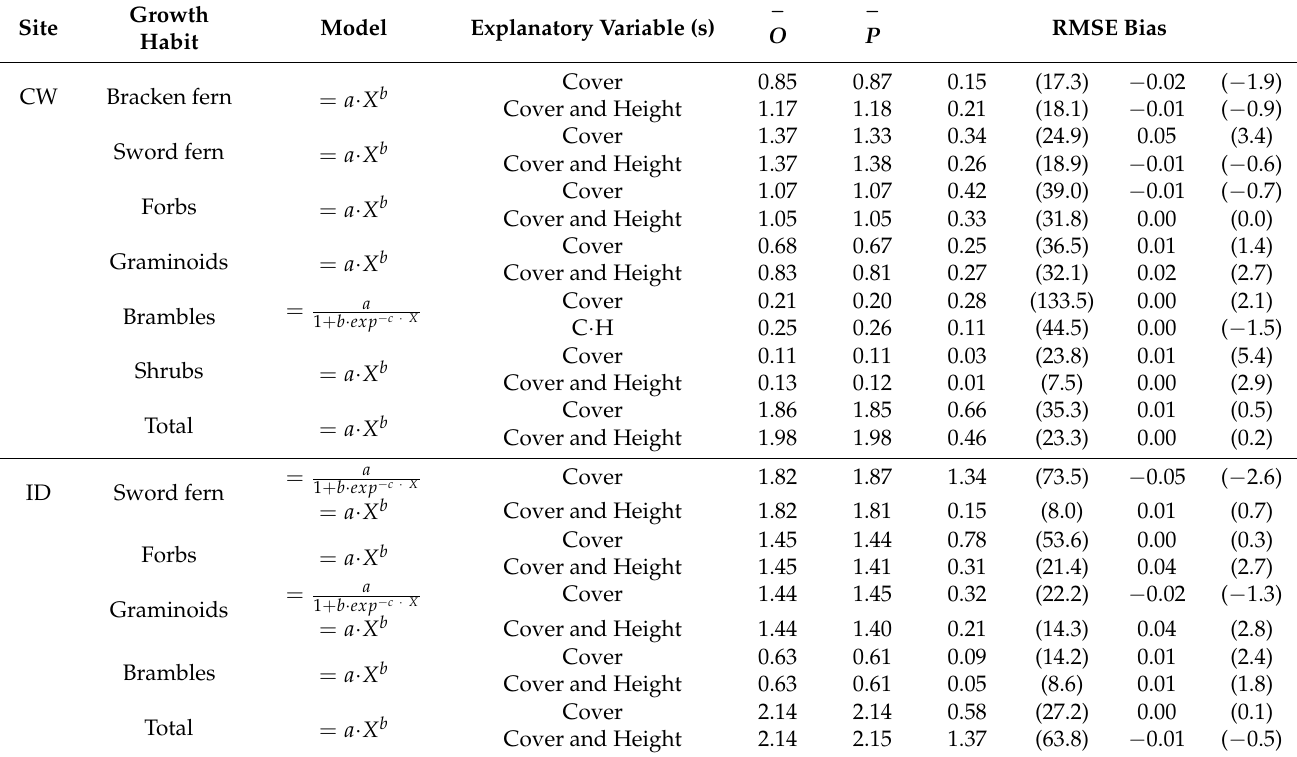
Table 5. Summary of model evaluation statistics using 10-fold cross-validation for biomass estimations for each growth habit of early-seral vegetation growing in Western